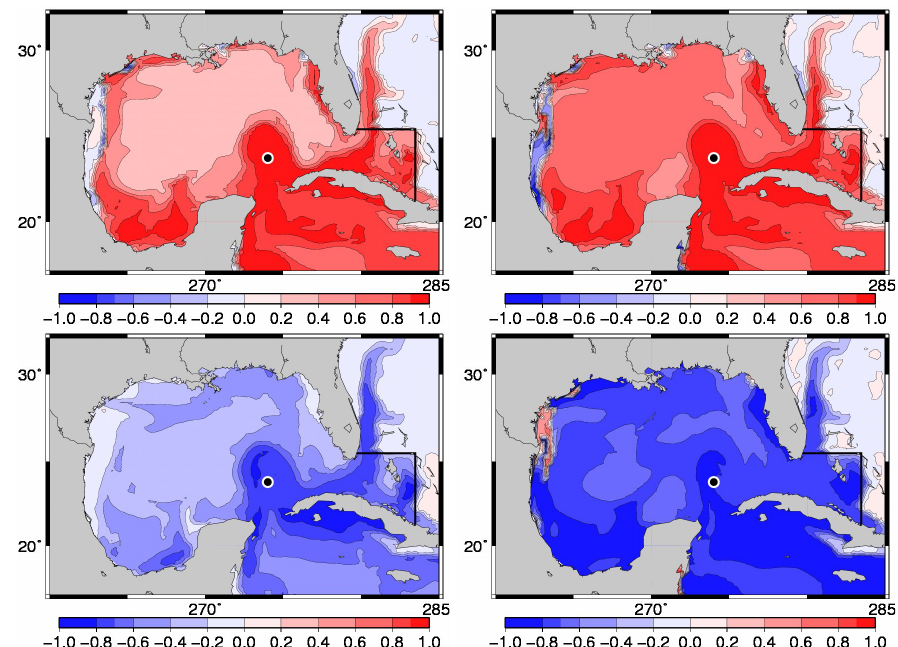
Fig. 10. Phytoplankton (top panels) and nitrate (bottom panels) horizontal correlation structure with respect to phytoplankton at 86 ◦ W 23.8 ◦ N (Gulf of Mexico), without anamorphosis (left panels), and after local anamorphosis transformations (right